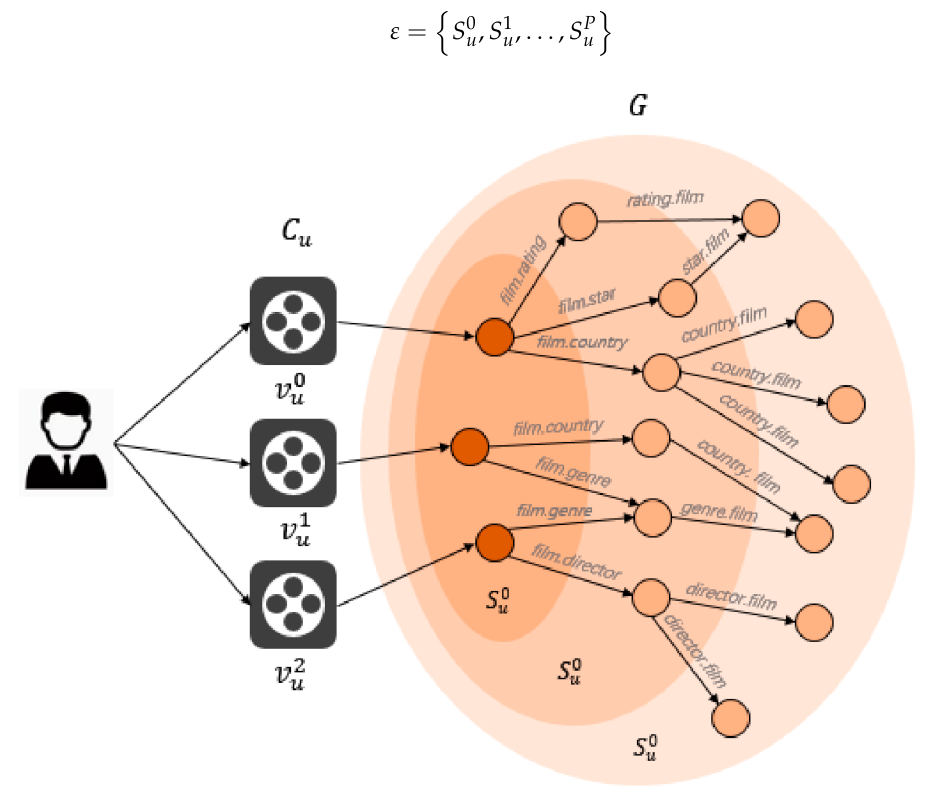
Figure 3. Entity propagation process in the context of movie